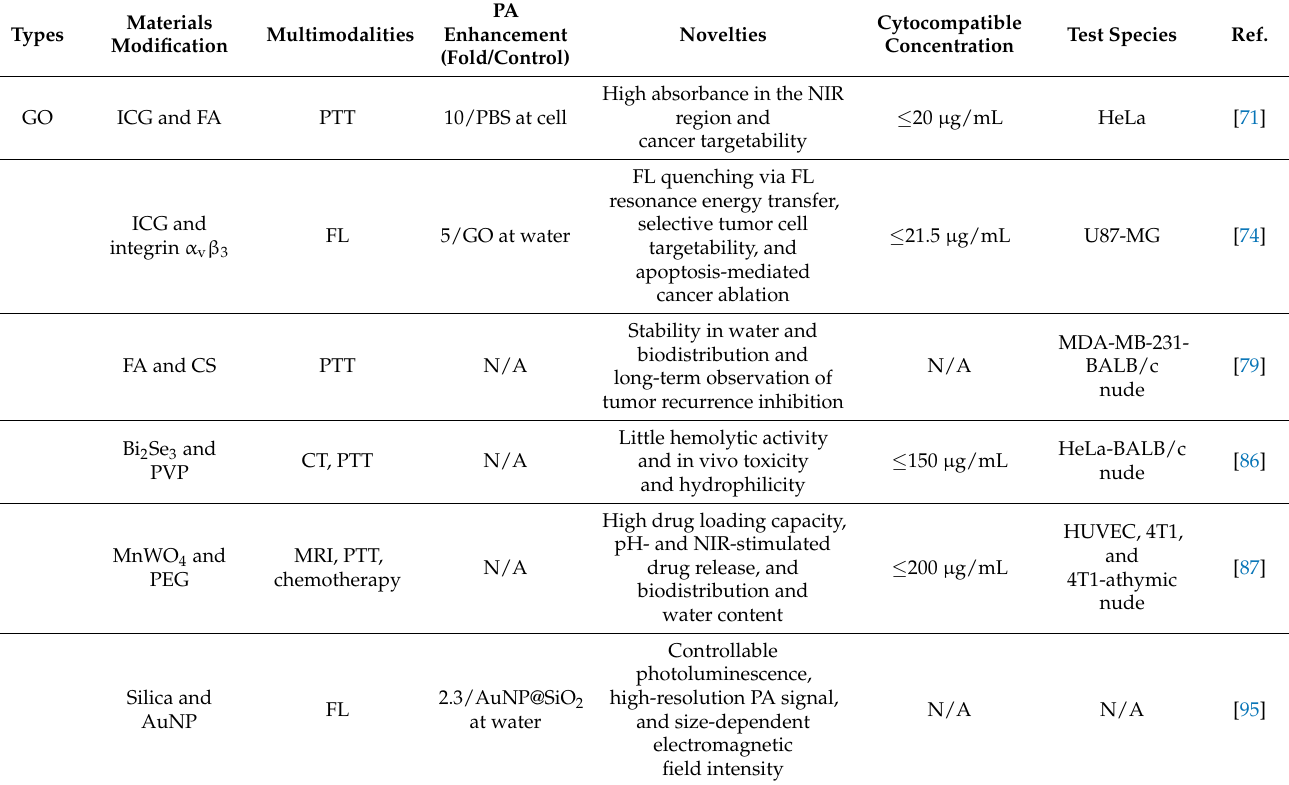
Table 2. G-based PAI. Each research was classified by G types, modification, abbreviation, theragnosis multimodalities, PA signal enhancement, novelties, maximum cytotoxicity concentration, and test species. AuNP, gold nanoparticle; APTES, 3-aminopropyltriethoxysilane; AuNS, gold nanostar; BSA, bovine serum albumin; CCK-8, cell counting kit 8; CS, chitosan; DODAB, dimethyldioctadecylam- monium bromide; DOPE, 1,2-dioleoyl-sn-glycero-3-phosphoethanolamine; DOX, doxorubicin; FA, folic acid; FL, fluorescence; GNP, graphene nanoparticle; GQD, graphene quantum dot; GSP, gold superparticle; ICG, indocyanine green; IONP, iron oxide nanoparticle; MRI, magnetic resonance imaging; NR, nanorod; ND, nanodiamond; NIR, near infrared; O-MWGNR, oxydized graphene multi-walled nanorod; PAA, polyacrylic acid; PBS, phosphate-buffered saline; PDA, polydopamine; PEG, polyethylene glycol; PET, positron emission tomography; PT, photothermal; PTT, photothermal therapy; PVP, polyvinylpyrrolidone; US, ultrasound; SERS, surface-enhanced Raman scattering; rGO, reduced graphene oxide; TPI, two-photon